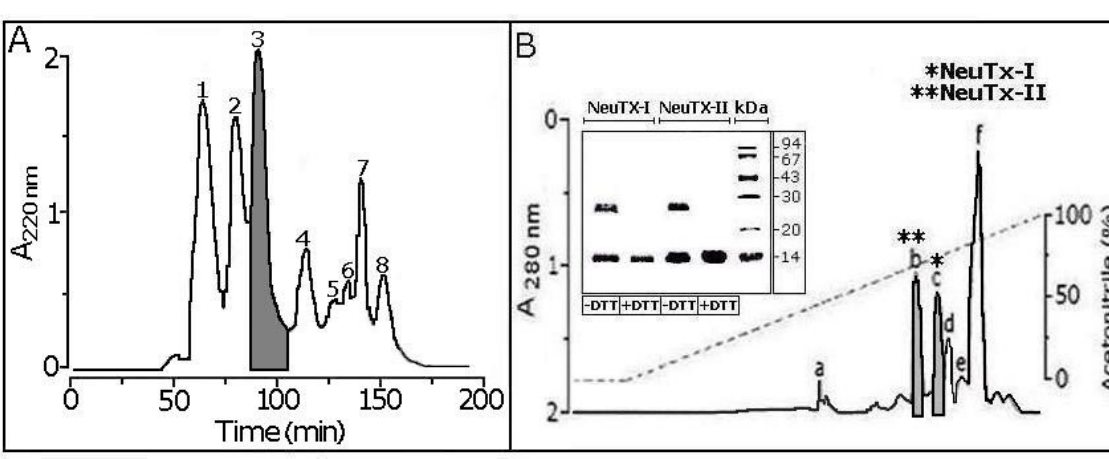
Figure 1. Purification of NeuTXs-I and II. A: Molecular exclusion HPLC of Bothrops neuwiedi pauloensis venom (25mg). Fractions were collected and the elution profile was monitored at 280nm. B: Repurification of fraction 3 by reverse phase HPLC. NeuTX-I (*) was recovered in peak c and NeuTX-II (**) was recovered in peak b. The inset shows a Tricine-SDS-PAGE gel of the toxins in the absence and presence of dithiothreitol (DTT).